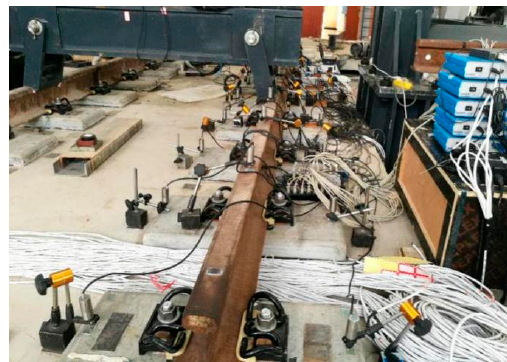
Figure 13. Loading mode of working condition 2.